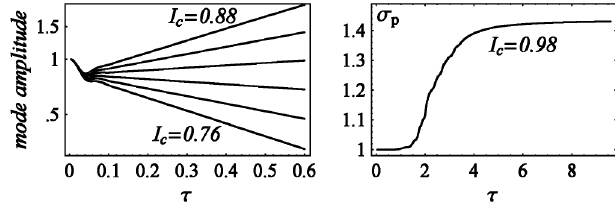
FIG. 3. Coasting beam. Left: Logarithm of the amplitude of Fourier mode (cid:3) n (cid:2) 702 (cid:4) versus time for six values of the current (cid:2) 0 : 76 and I (cid:2) 0 : 88 in steps of (between I parameter I c c c . 0.024). Right: Evolution of normalized rms energy spread (cid:8) p In both pictures is the normalized